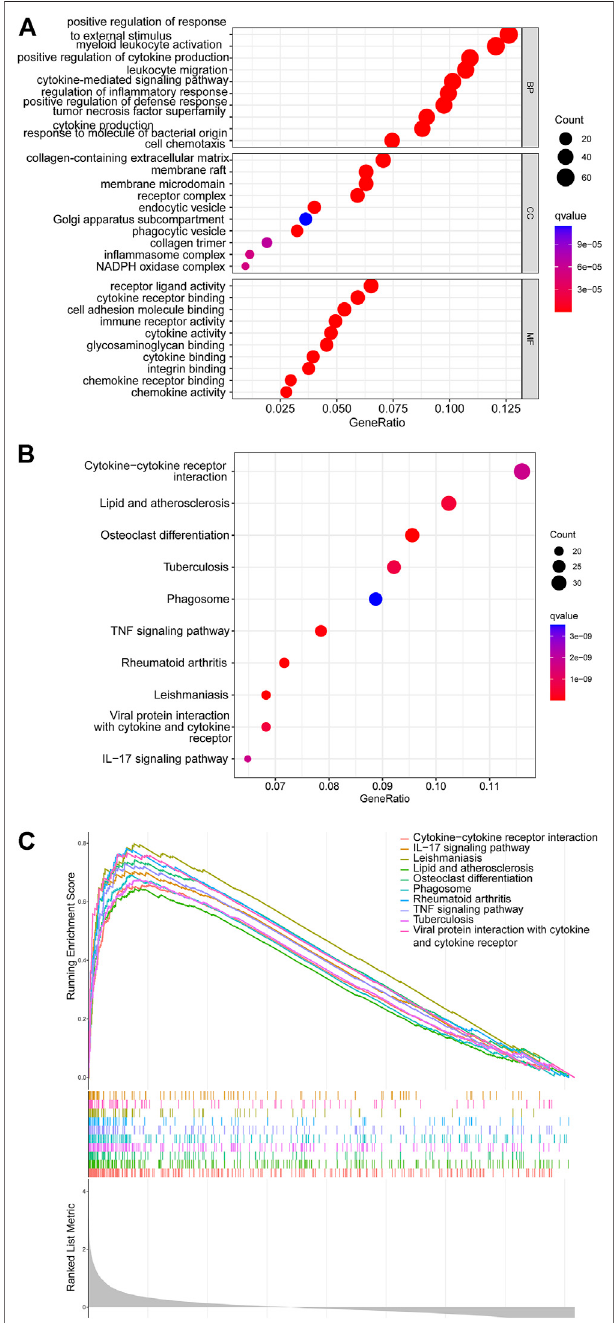
FIGURE 3 | The results of functional enrichment analyses. (A) GO analysis results of DEGs. (B) KEGG analysis results of DEGs. (C) GSEA pro fi les showed the ten signi fi cant GSEA